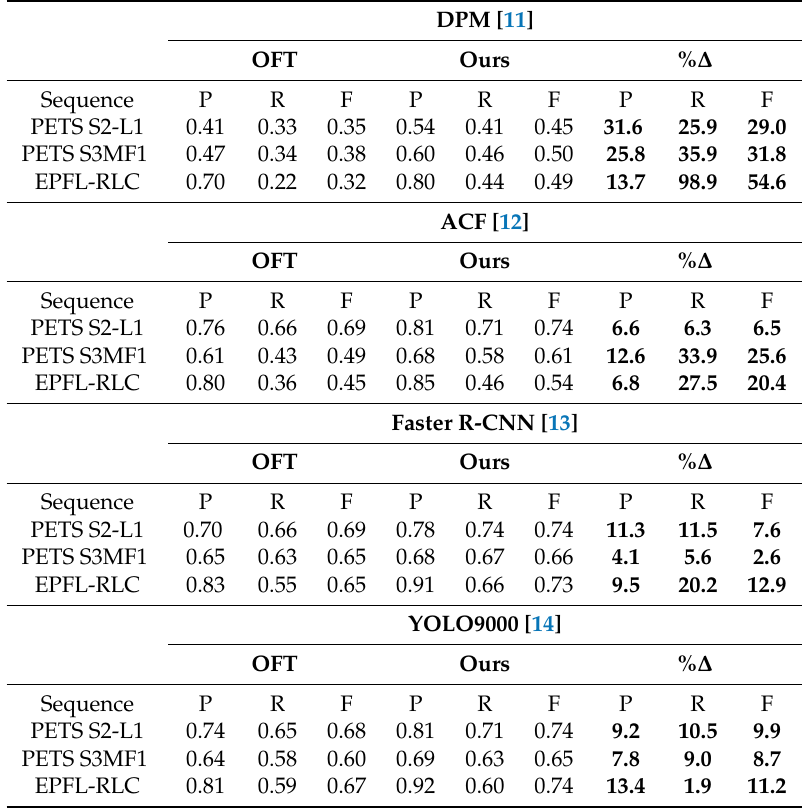
Figure 5. Visual examples of the faster R-CNN [13] detections of all cameras transferred to the evaluation viewpoint. Each camera bounding box is represented with a different color. Sequence PETS S2-L1, Frame 102 ( a ), and sequence PETS S3MF1, Frame 78 ( b ). Table 4. Precision (P), Recall (R), and F-score (F) values obtained for the four detection algorithms and comparison with the use of the Optimal Fixed Threshold